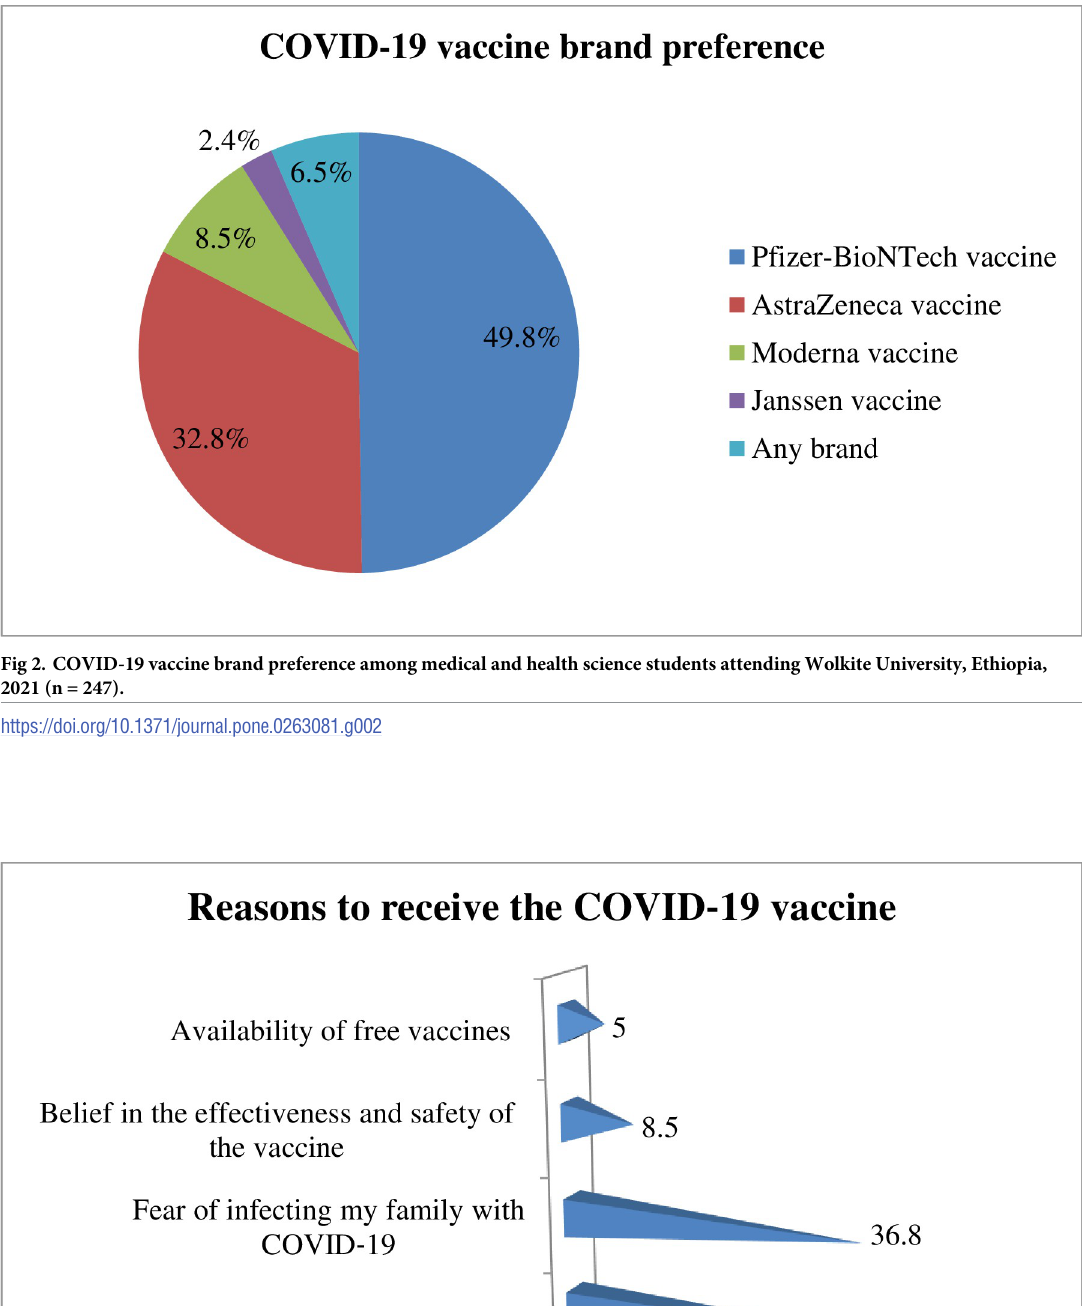
PLOS ONE | https://doi.org/10.1371/journal.pone.0263081 January 25,